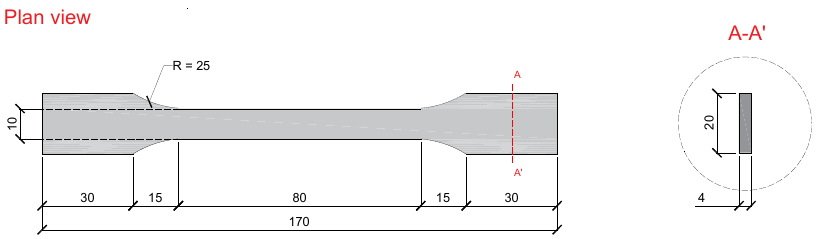
Figure 5. Geometry of the epoxy adhesive specimens used in the tensile tests. All units in (mm).